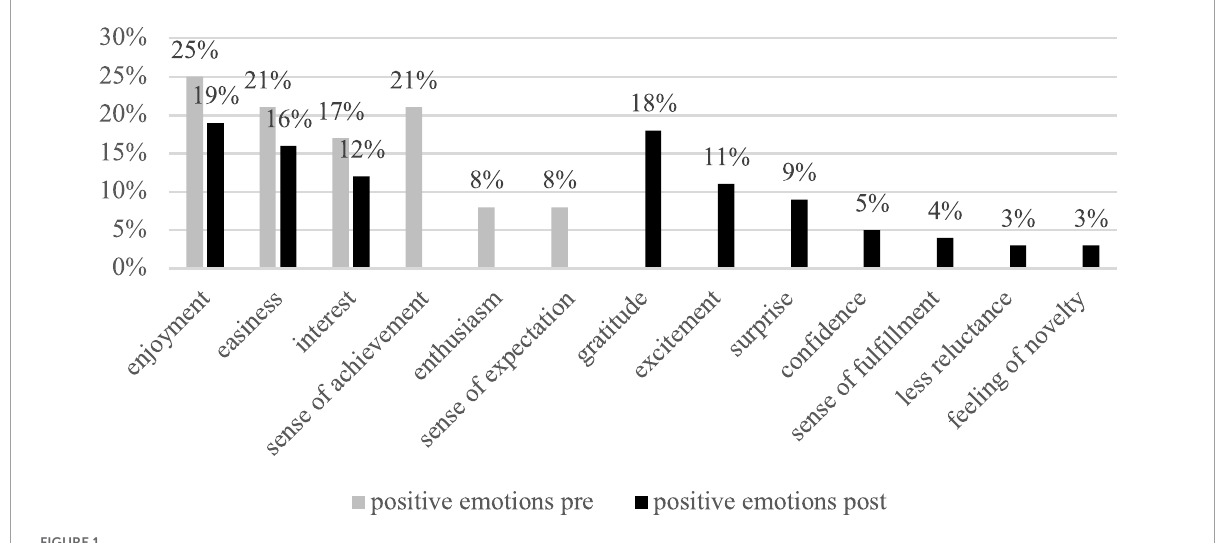
FIGURE1 Overall positive emotions from pre- and post-written narratives by the 32 students.